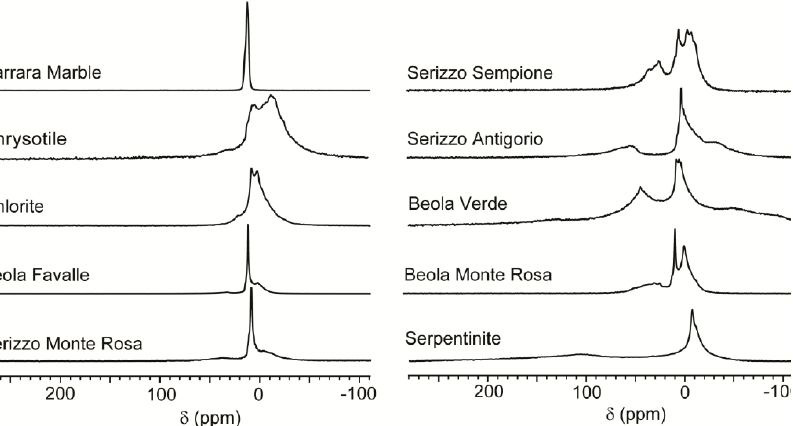
Figure 14. CF HP 129 Xe NMR spectra of different building stone materials. Reprinted from reference [138].